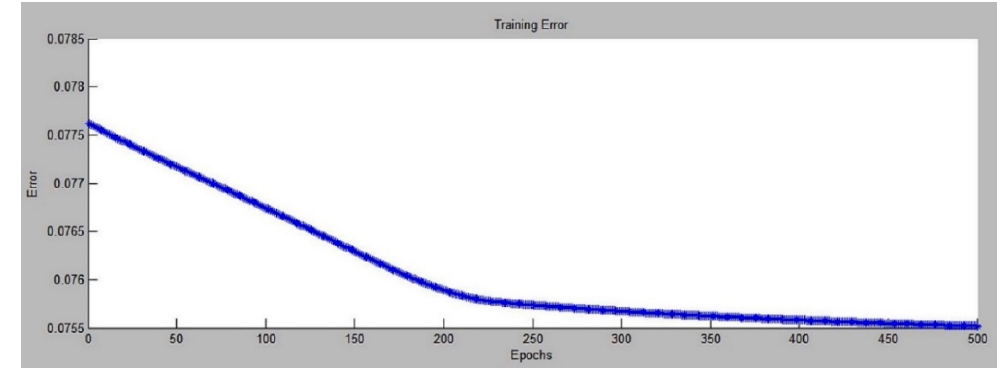
Figure 4. Fuzzy rule architecture of the Gaussian membership function